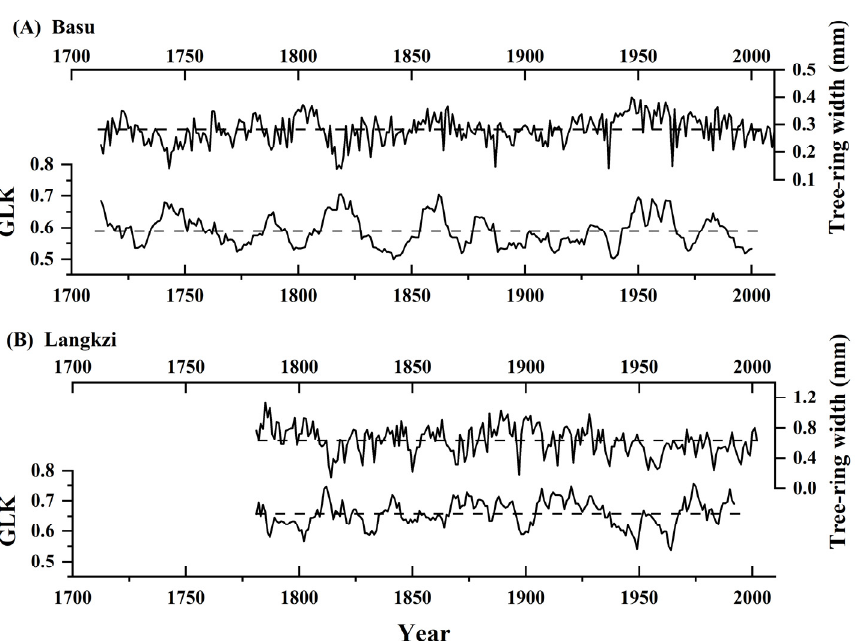
Figure 5. Chronologies of the averaged ring-width sequences of the isolated trees in comparison with the 11-year sliding window of GLK values (placed in the first year of the window) of ring- width sequences of the isolated trees for the Basu treeline ( A ) and the Langkazi treeline ( B ) in Tibet. Horizontal broken lines represent the mean for each series.